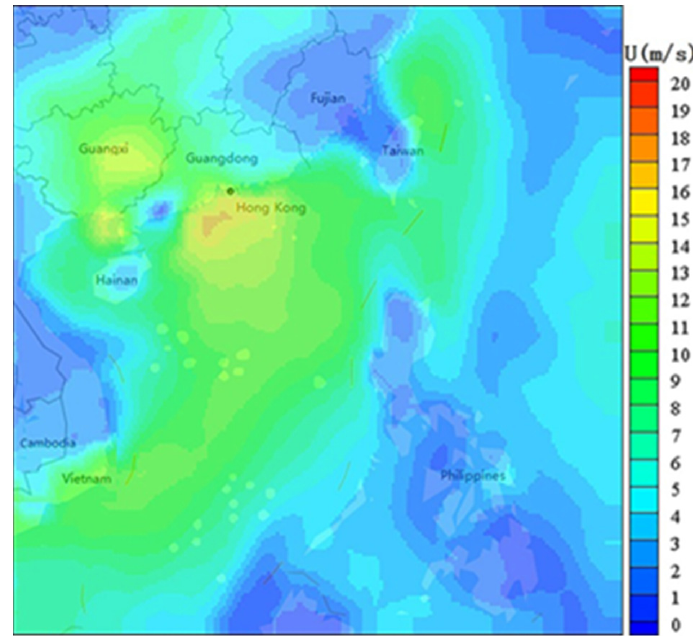
Figure 4. Cloud map of the ECMWF wind field of Typhoon Mangkut.